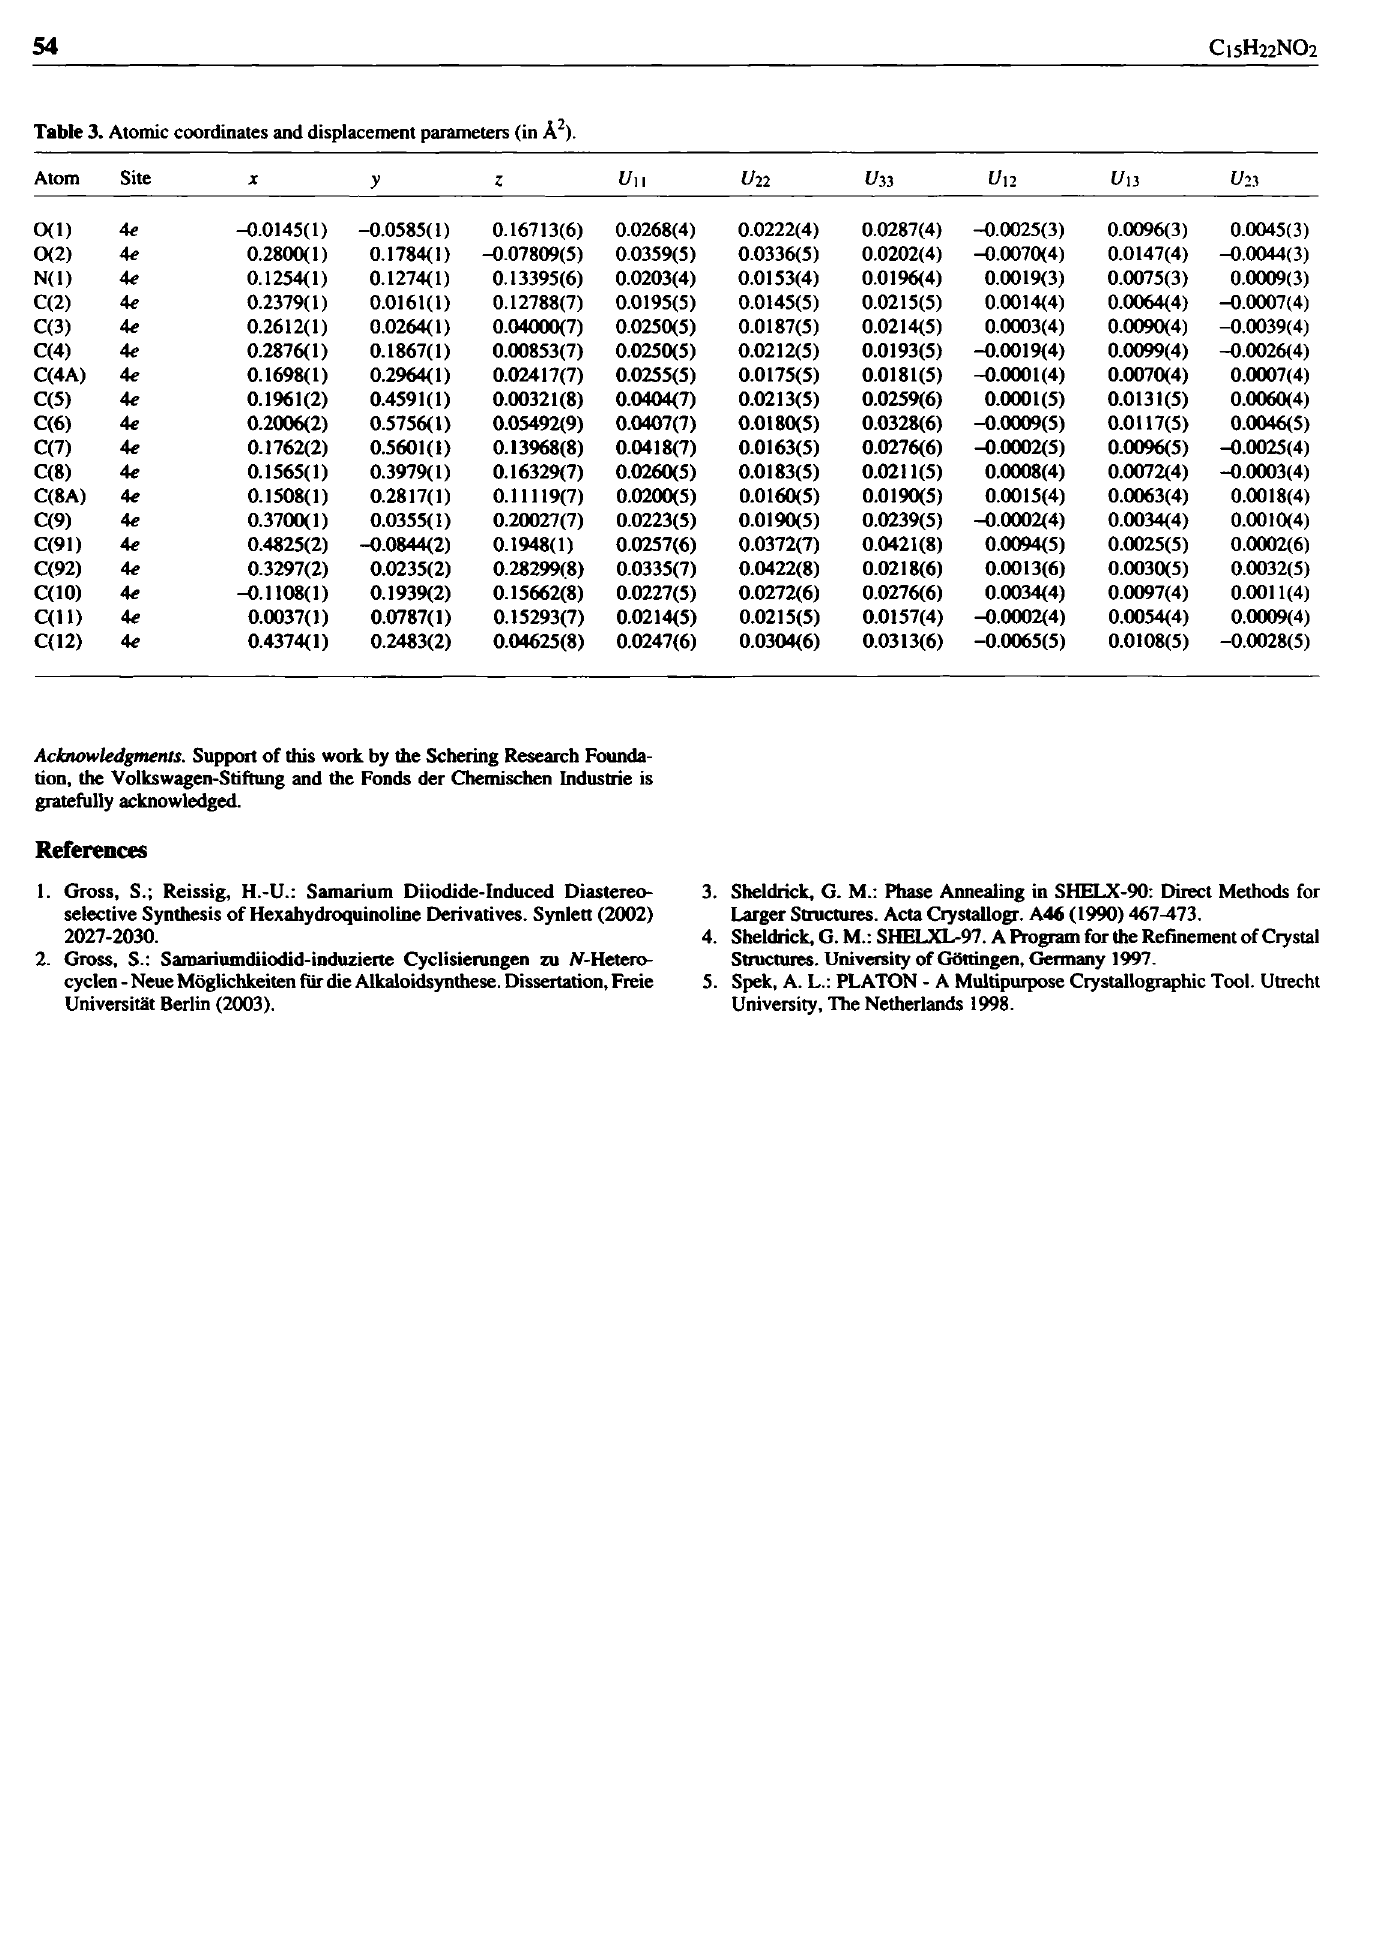
Table 3. Atomic coordinates and displacement parameters (in Â 2